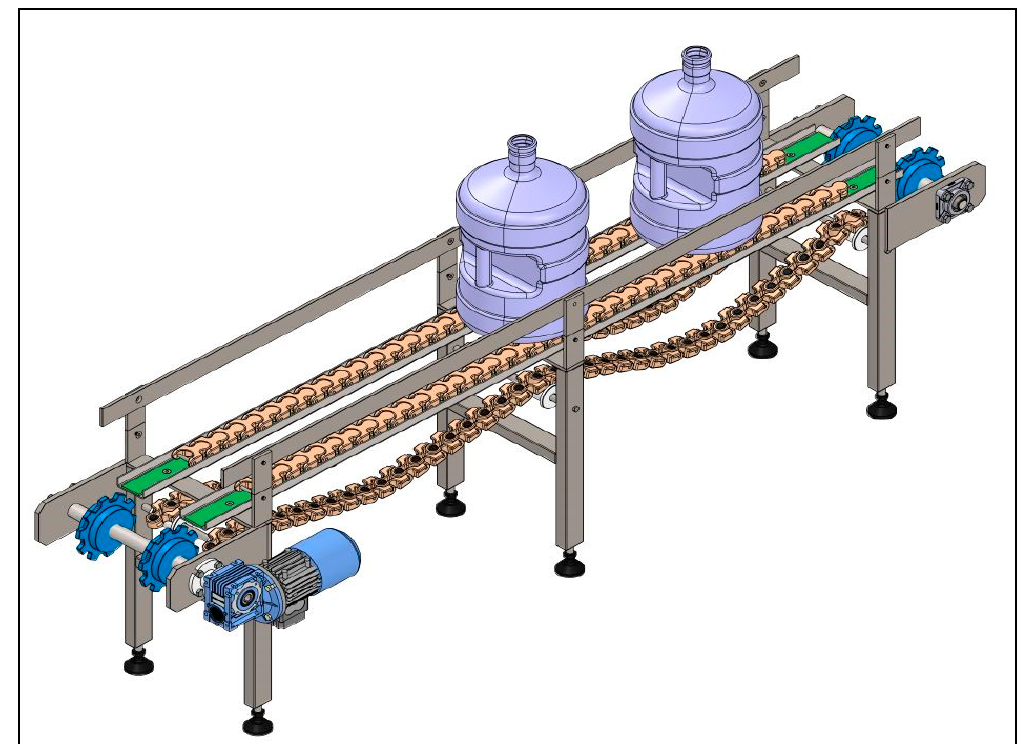
Figure 8. Concept 1—Dual lane flex type conveyor system.